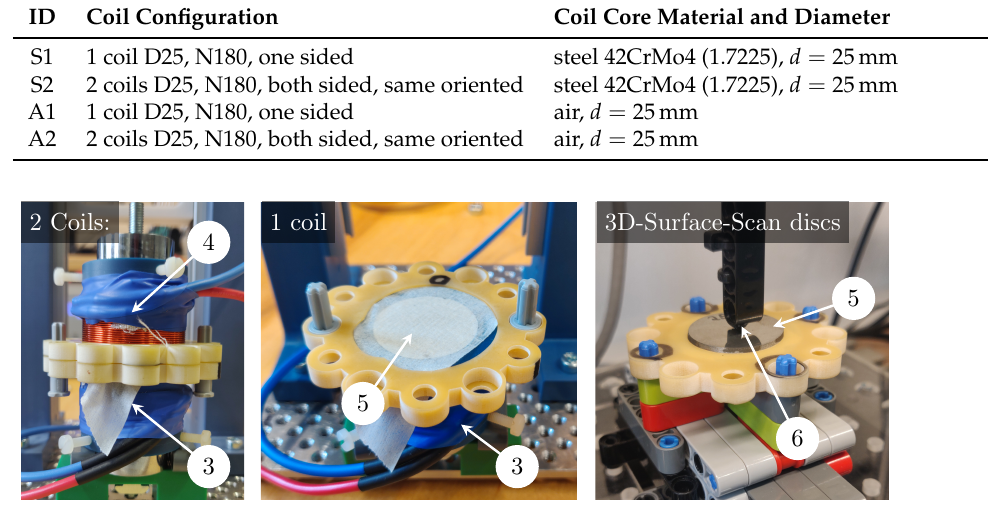
Figure 5. Magnetization modules for the disc samples with two coils (3,4) and the sample (5) in- between (left), one coil (3) with the sample (5) on top of it fixed with a piece of tape (middle) and the 3D-Surface-Scanner for measuring the residual magnetic flux density on top of the discs (5) with a single Hall-probe